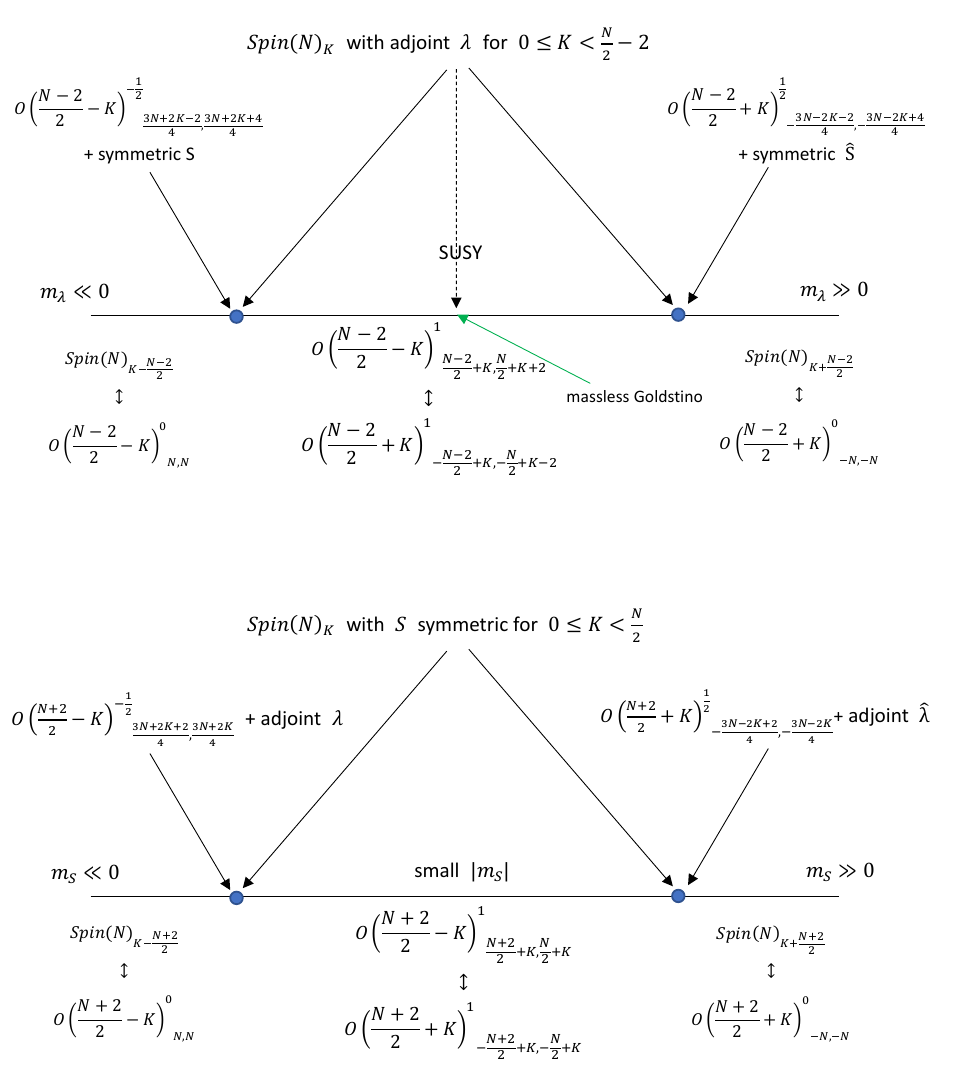
Figure 5: The phase diagrams of Spin ( N ) gauge theory coupled tensor fermions. The infrared TQFTs, together with relevant level-rank duals are shown along the bottom. The blue dots indicate the transitions from the semiclassical phase to the quantum phase. This proceeds through a tensor transition described by a dual theory, which covers part of the phase diagram. Across these tensor transitions O ( L ) 0 and O ( L ) 1 are exchanged. At a special value of the mass in the quantum phase of the adjoint theory, a massless goldstino